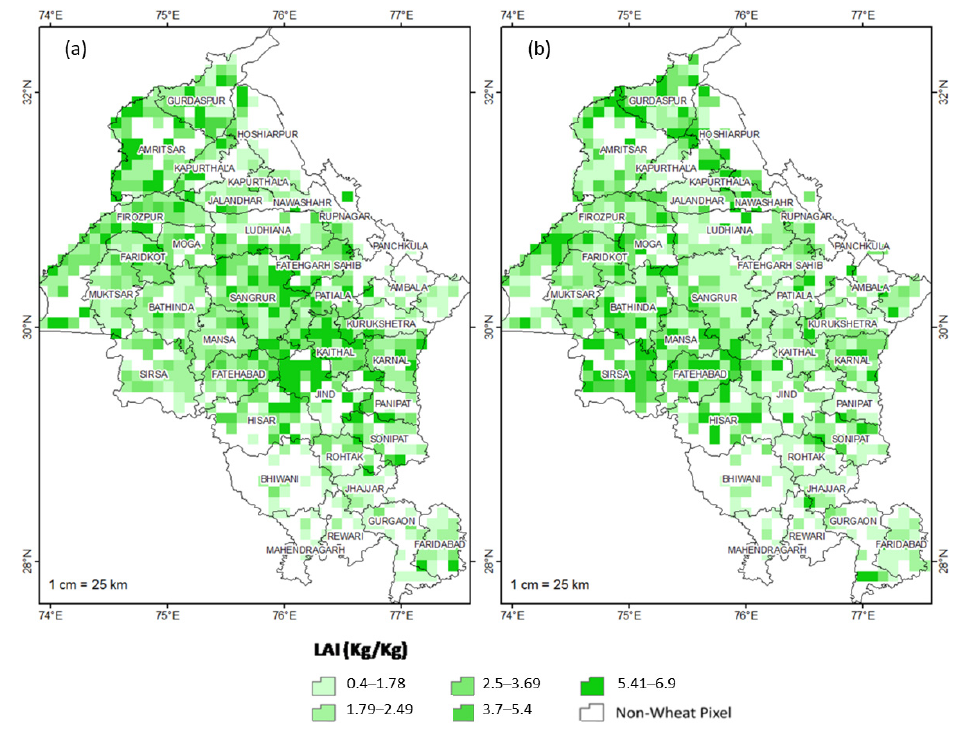
Figure 8. Spatial LAI maps. ( a ) MODIS LAI maximum values across the growing season; ( b ) F1 simulated maximum values across the growing season.